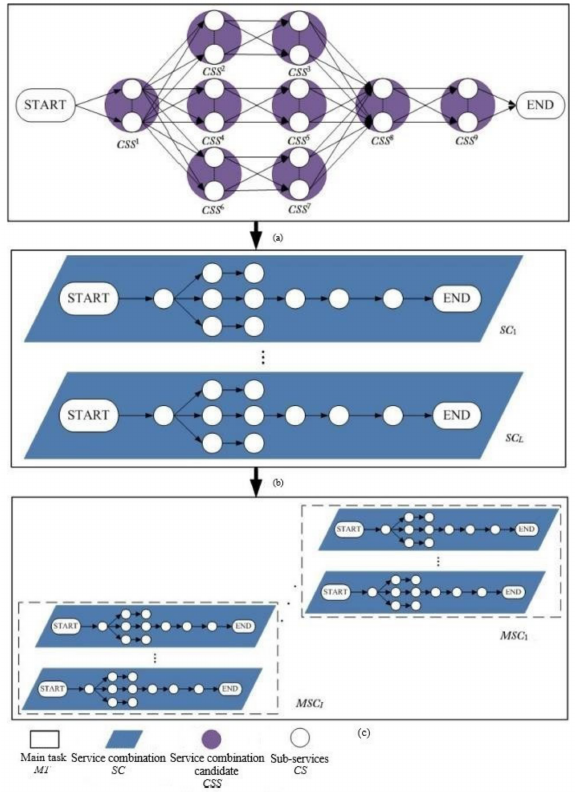
Figure 2. Global optimization strategy for product customization process. ( a ) Service Combination. ( b ) Service Combination Candidate. ( c ) MSC Multi-service